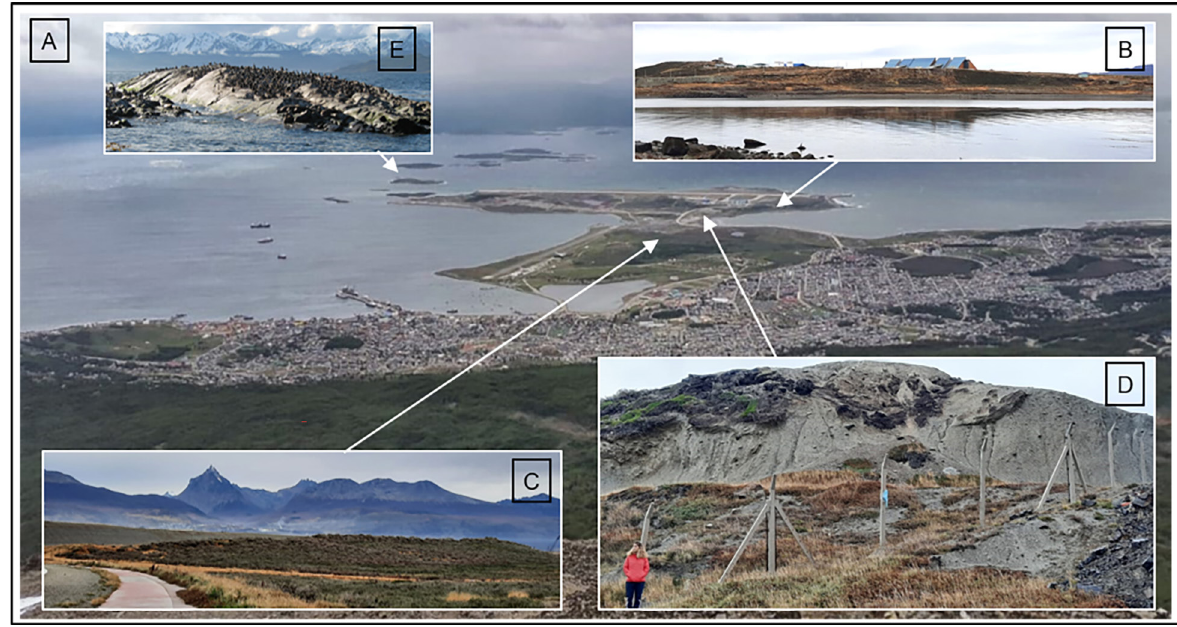
Fig. 10. A – Ushuaia Peninsula basal moraines in Ushuaia city surroundings and rocky stream-lined islands in the Beagle Channel; B – basal moraine flattened by the airport construction, the visible building; C – basal moraine topography forming part of the peninsula; D – basal till exposure showing few boulders into a silty- clay matrix; E – glacial abrasion on the rocks of the island where marine mammals live in